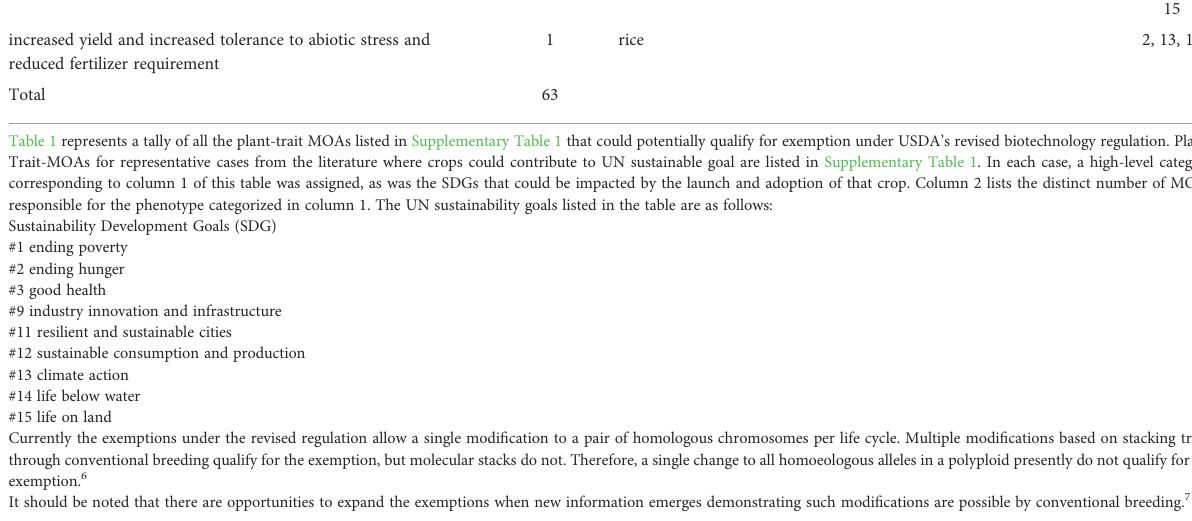
Table 1 represents a tally of all the plant-trait MOAs listed in Supplementary Table 1 that could potentially qualify for exemption under USDA ’ s revised biotechnology regulation. Plant- Trait-MOAs for representative cases from the literature where crops could contribute to UN sustainable goal are listed in Supplementary Table 1. In each case, a high-level